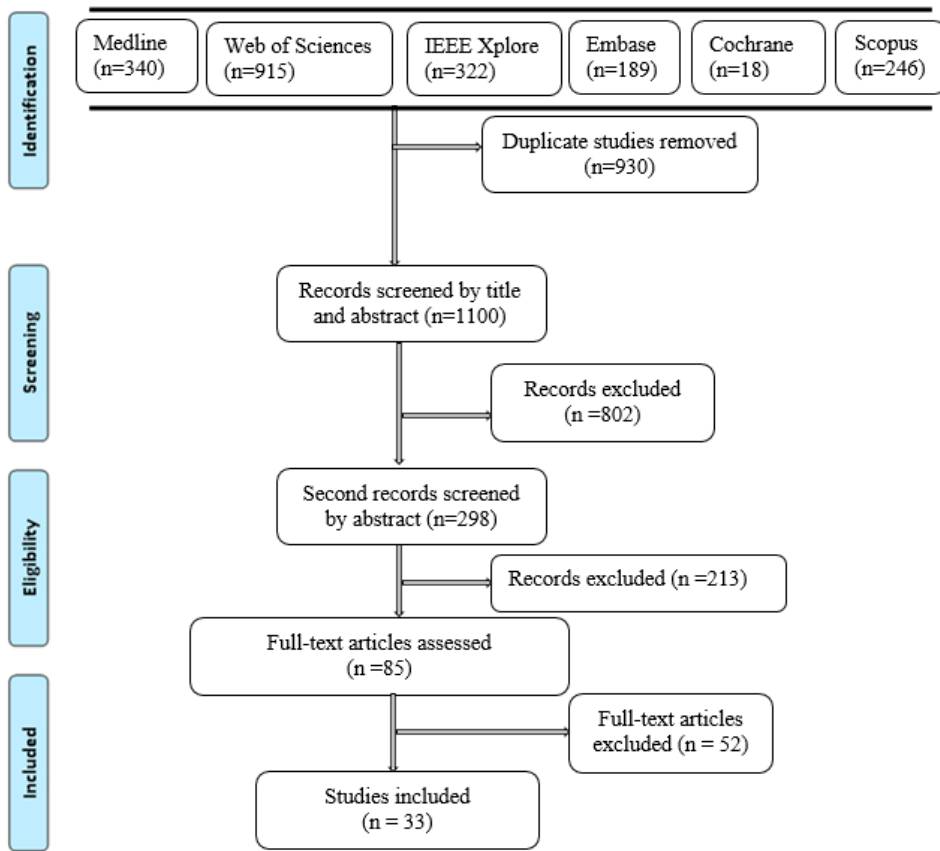
Figure 1. Flowchart of articles identification and selection process according to PRISMA guidelines.